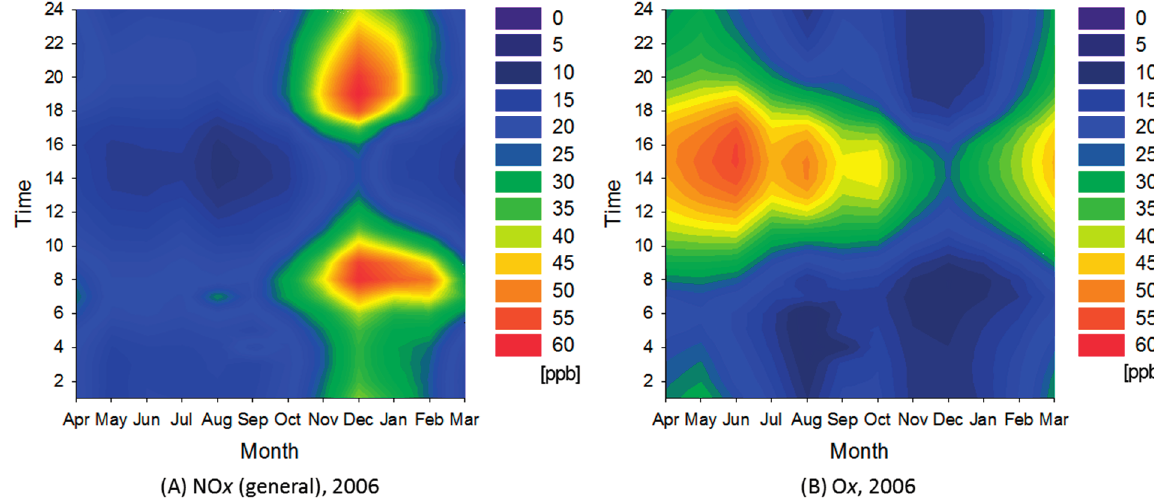
Figure 7. Contour maps for NO x and O x in cluster 2 for